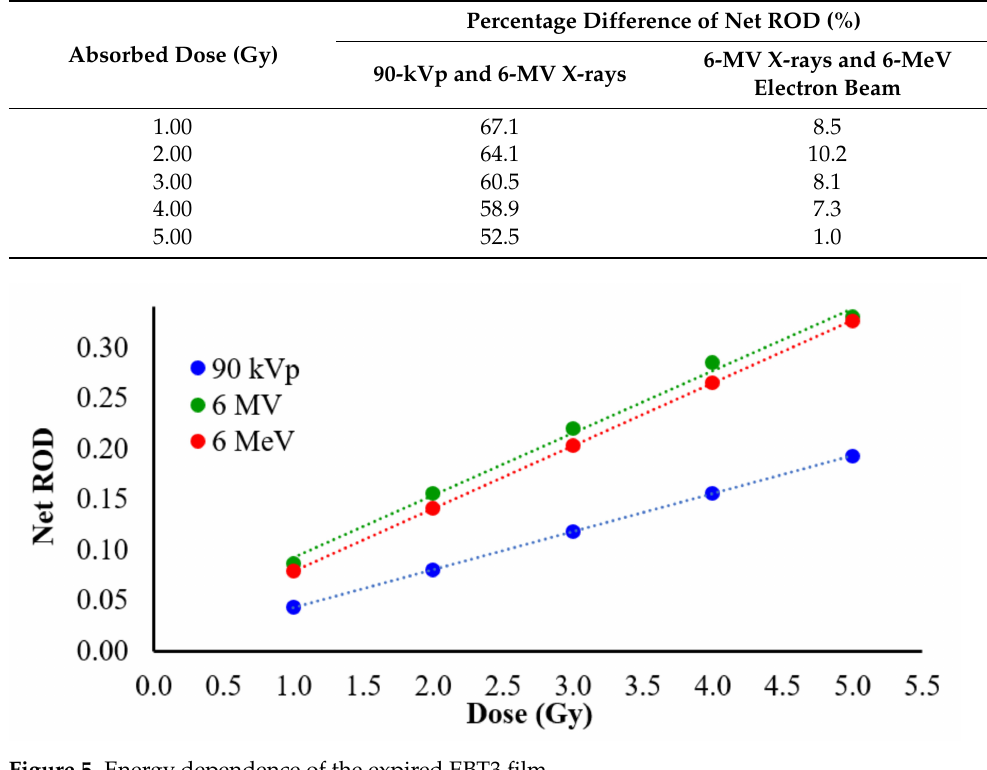
Table 7. Summary for the percentage difference of net ROD for 90-kVp and 6-MV photon beam.